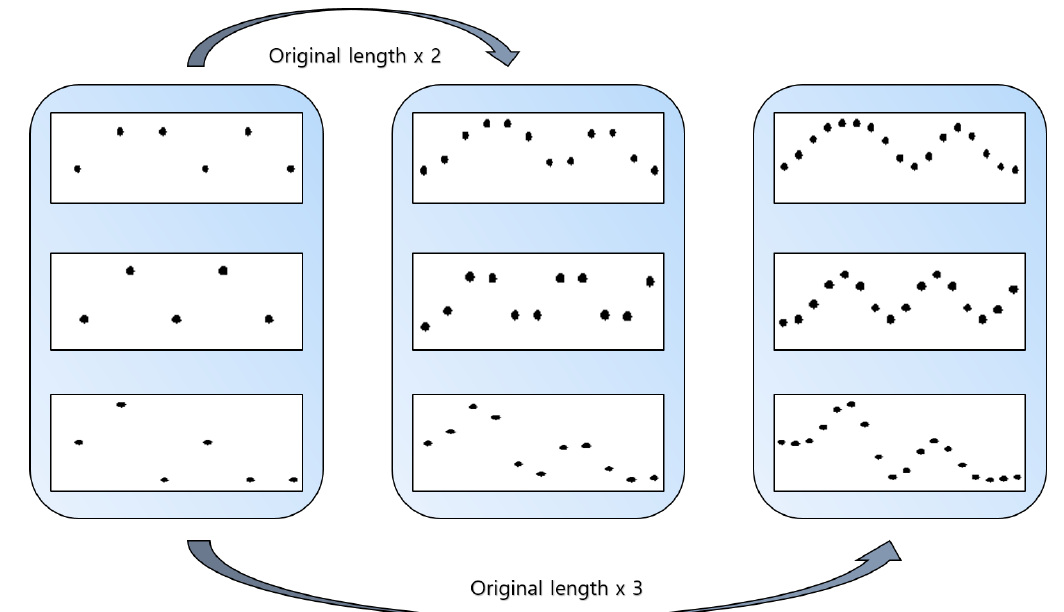
Figure 5. Sound events of increased length obtained via bicubic interpolation.